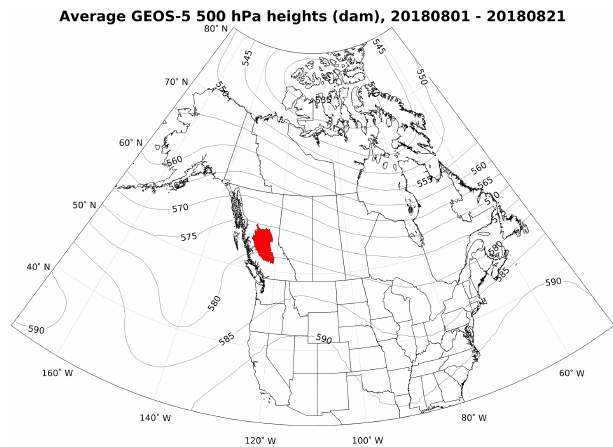
Figure 9. Average GEOS-5 analysis 500hPa heights (dam) over Canada and the US from 1 to 21 August 2018. The area in red is the Fraser Plateau and Basin complex ecoregion from the Terrestrial Ecoregions of the